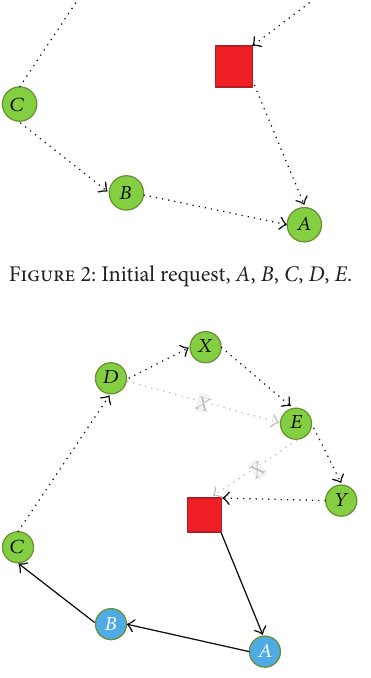
Figure 3: New requests for consideration.